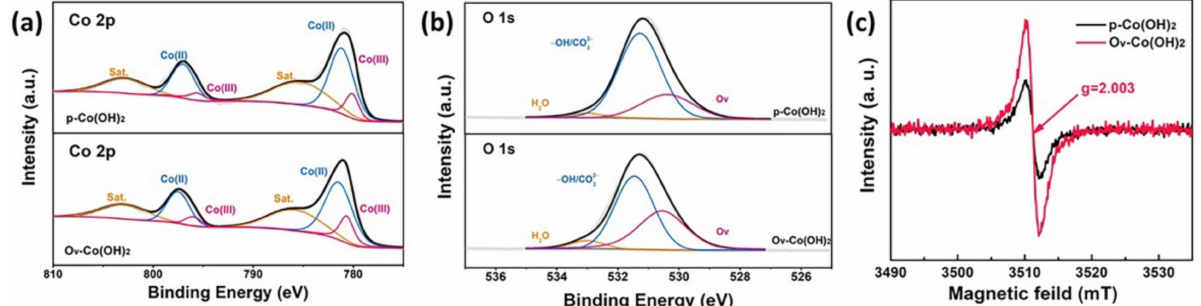
Figure 3. X-ray photoelectron spectra of Co 2p ( a ) and O1s ( b ) for p –Co(OH) 2 and O V –Co(OH) 2 ; ( c ) electron spin resonance spectra of O V –Co(OH) 2 and p –Co(OH) 2